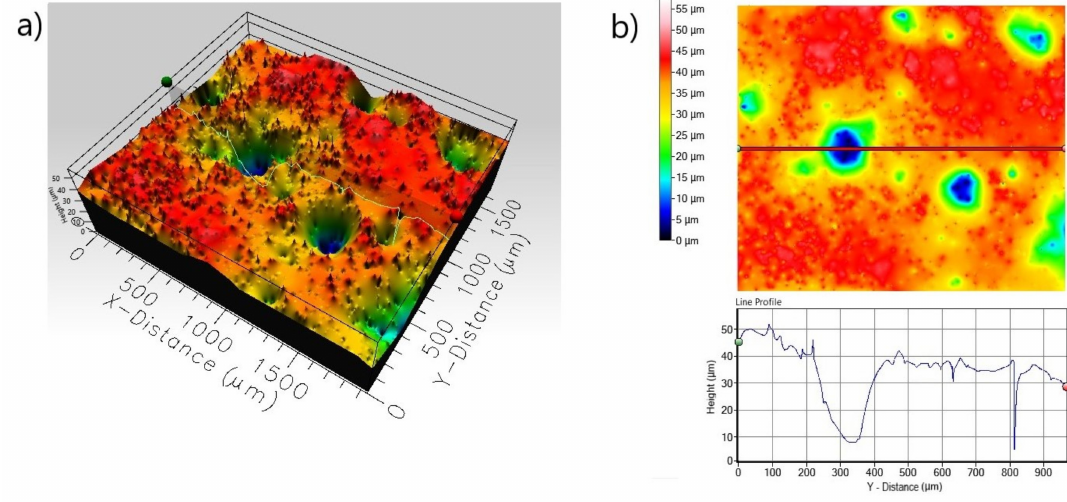
Figure 11. 3D profile ( a ) and 2D profile ( b ) of the corroded surface of non-borided Inconel ® 600 alloy after the corrosion resistance test in a 3.5% NaCl